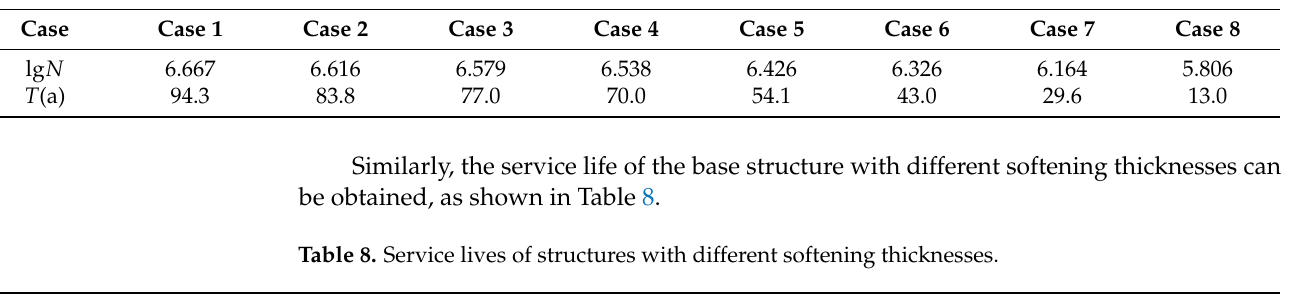
Table 7. Service lives of structures with different softening coefficients.